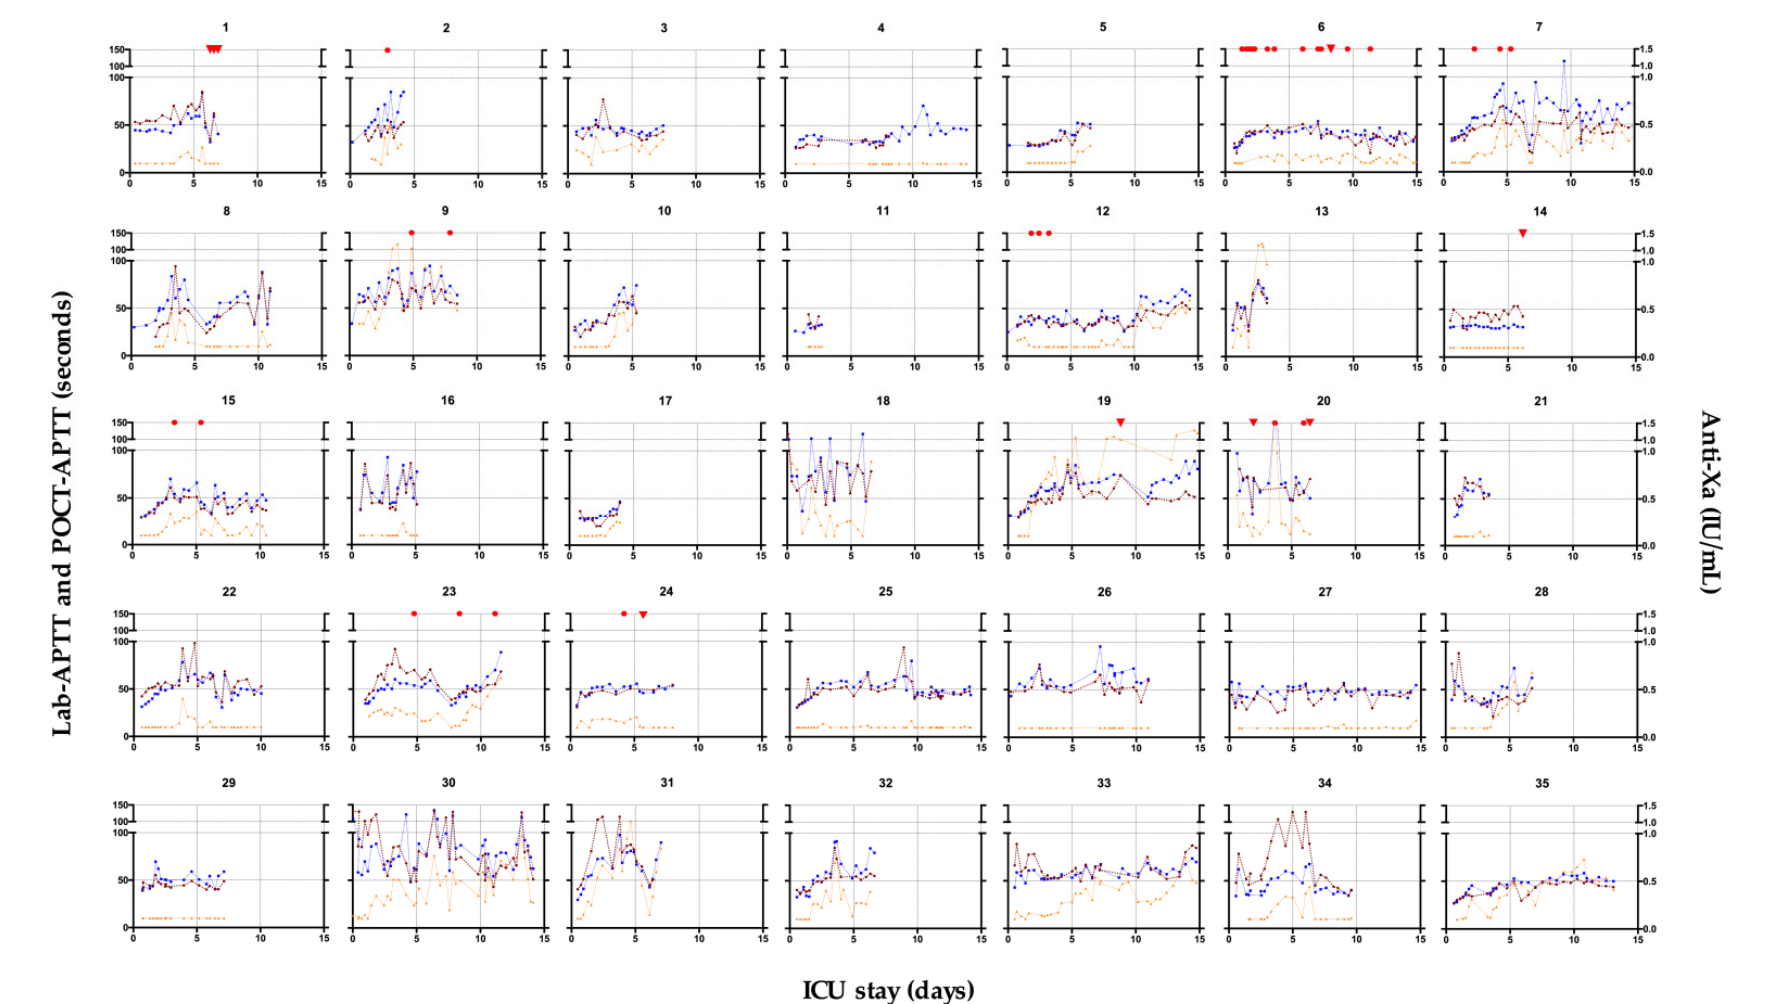
Figure 3. Temporal changes in POCT-APTT (brown), lab-APTT (blue) and anti-Xa (orange) levels during ICU stays for the 35 patients. Major or minor bleedings are symbolized by red triangles or dots above the graphs, respectively. No thrombotic events were recorded. APTT, activated partial thromboplastin time; ICU, intensive care unit; POCT, point-of-care testing.